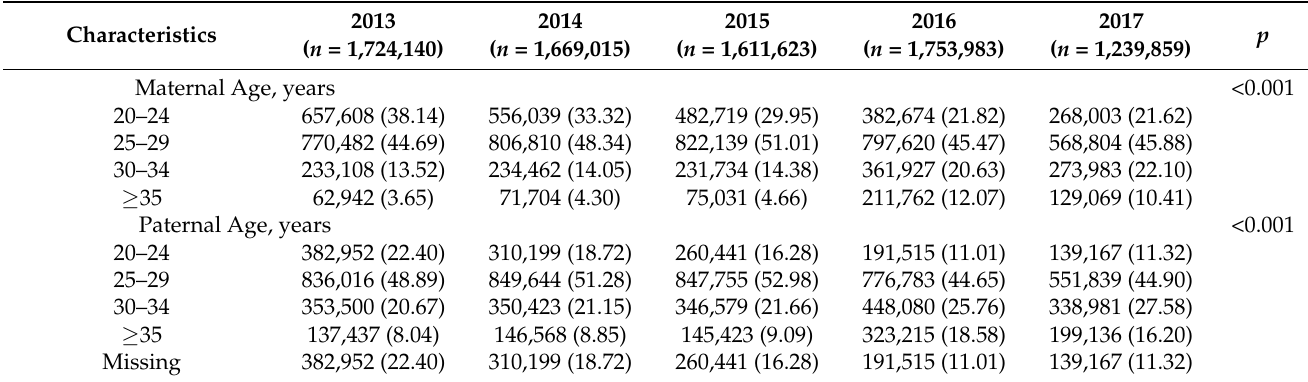
Table 1. Baseline characteristics of the included participants across LMP